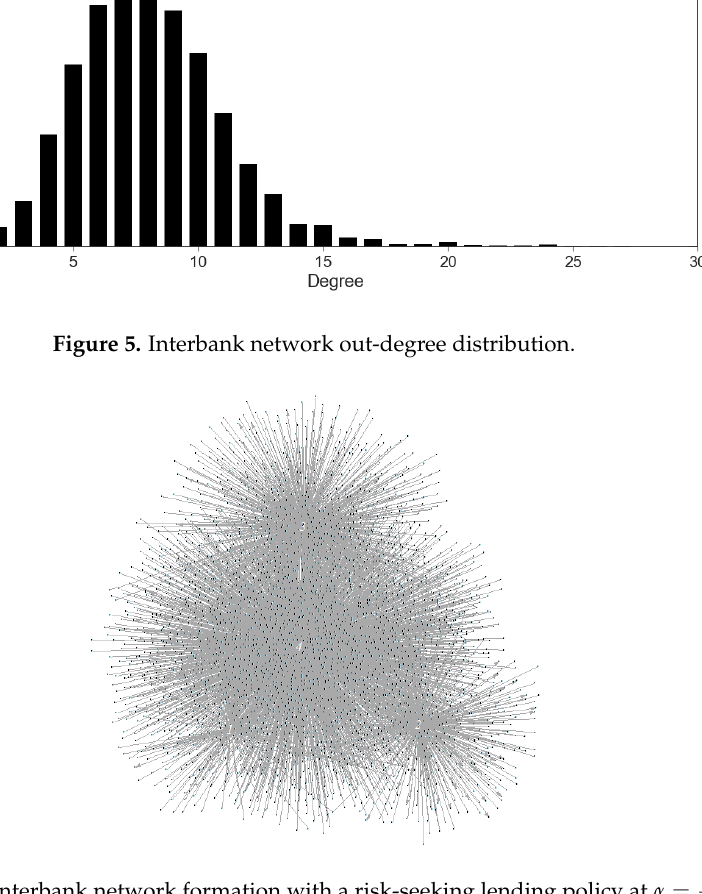
Figure 6. Interbank network formation with a risk-seeking lending policy at α = − 1.